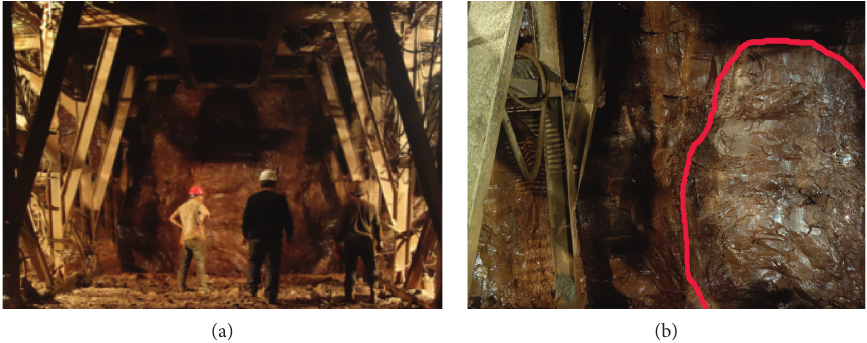
Figure 9: Blasting effect of double horizontal V-cut blasting.